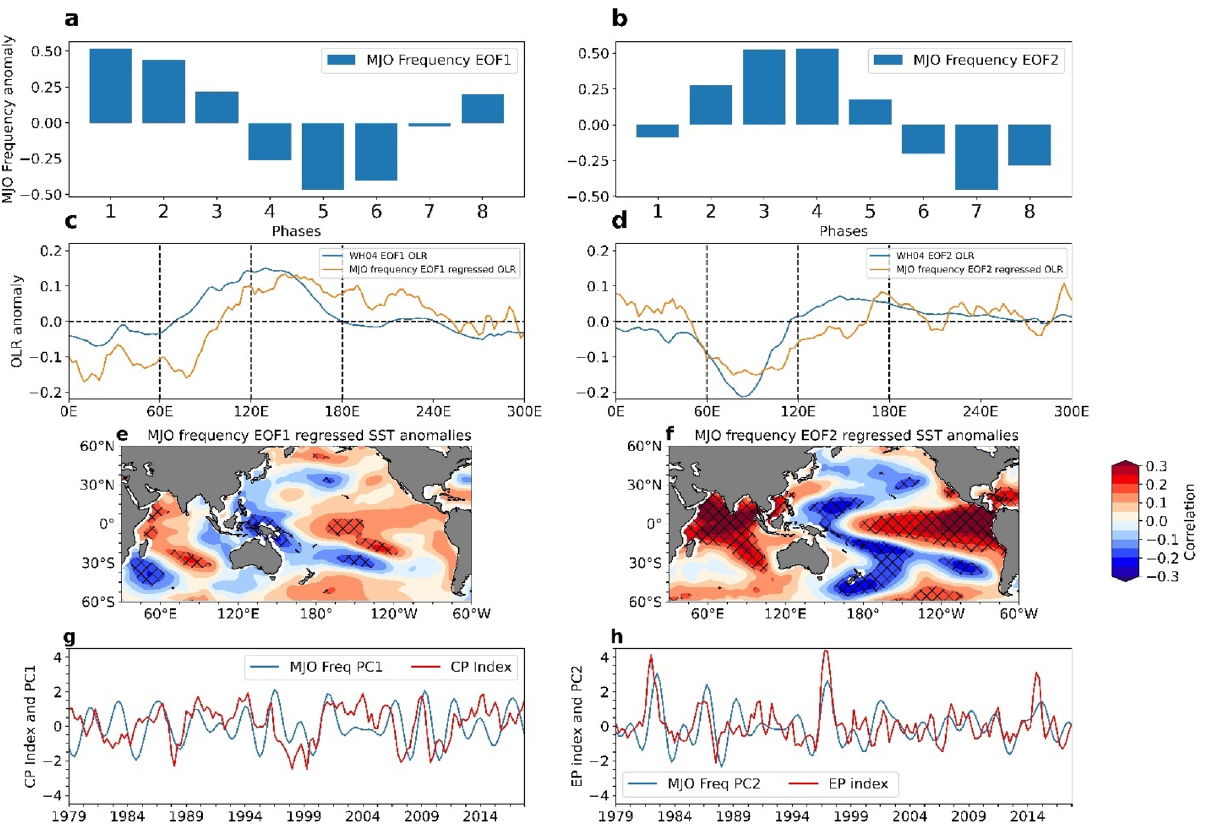
Figure 1. ( a , b ) First two leading spatial EOFs of MJO frequency variability (days). ( c,d ) Original WH04 RMM1 and RMM2 spatial pattern (blue lines) and spatial pattern of MJO frequency EOF1 and EOF2 of OLR. ( e,f ) SST anomalies related to MJO frequency EOF1 and EOF2 (hatched denote the locations having significant correlation with 90% confidence level). ( g ) represents PC1 timeseries (2–8 years bandpass filtered) (blue line) and CP El Niño index (red line). ( h ) shows PC2 timeseries (2–8 years bandpass filtered) (black line) and EP El Niño index (red